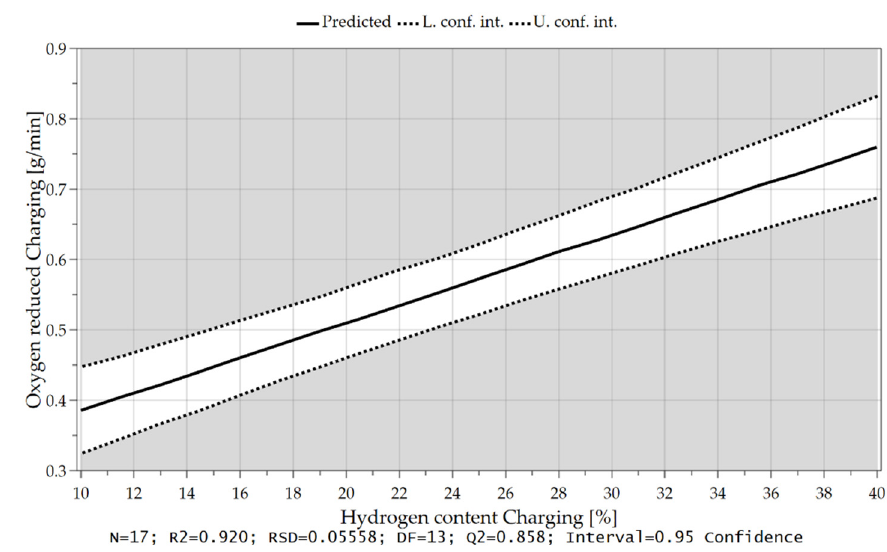
Figure 19. Oxygen removal rate as a function of the hydrogen content during charging.